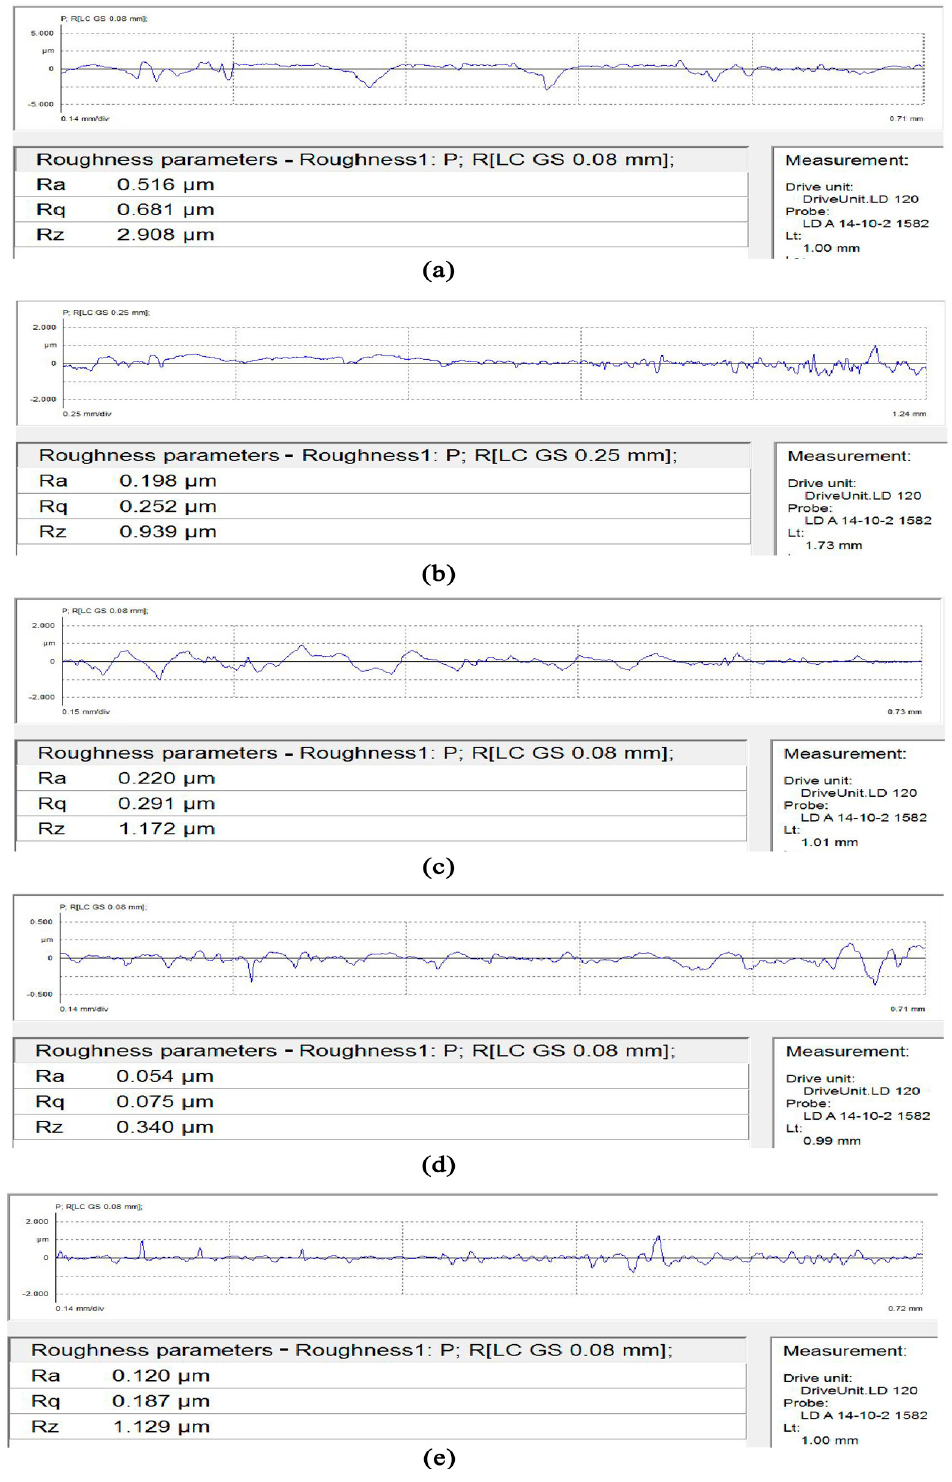
Figure 6. Surface roughness Ra detection diagram. ( a ) Original #0; ( b ) Sample #1; ( c ) Sample #2; ( d ) Sample #3; ( e ) Sample #4.